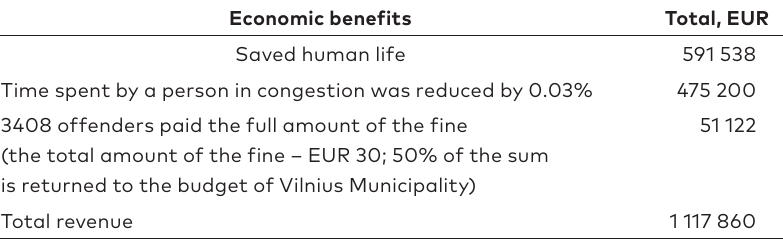
Table 1. Economic benefits of Automatic Incident